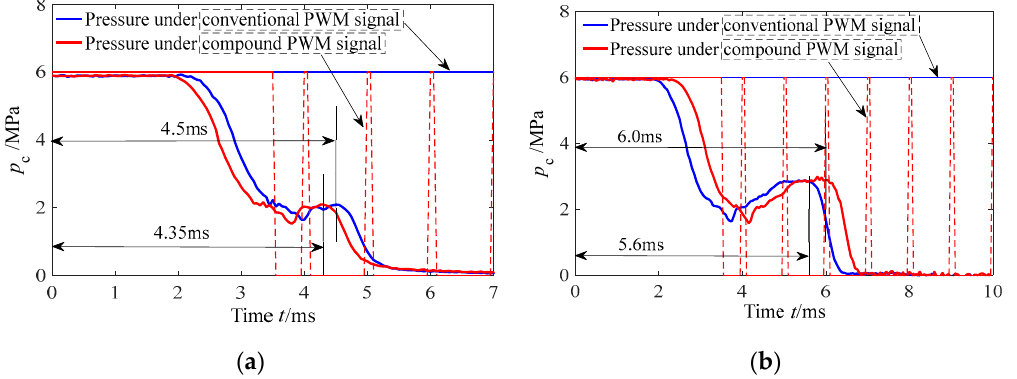
Figure 9. Comparisons of the pressure in the control chamber during the energized stage at the frequency of 10 Hz: ( a ) The adjustable maximum opening is 0.2 mm; ( b ) The adjustable maximum opening is 0.4 mm.